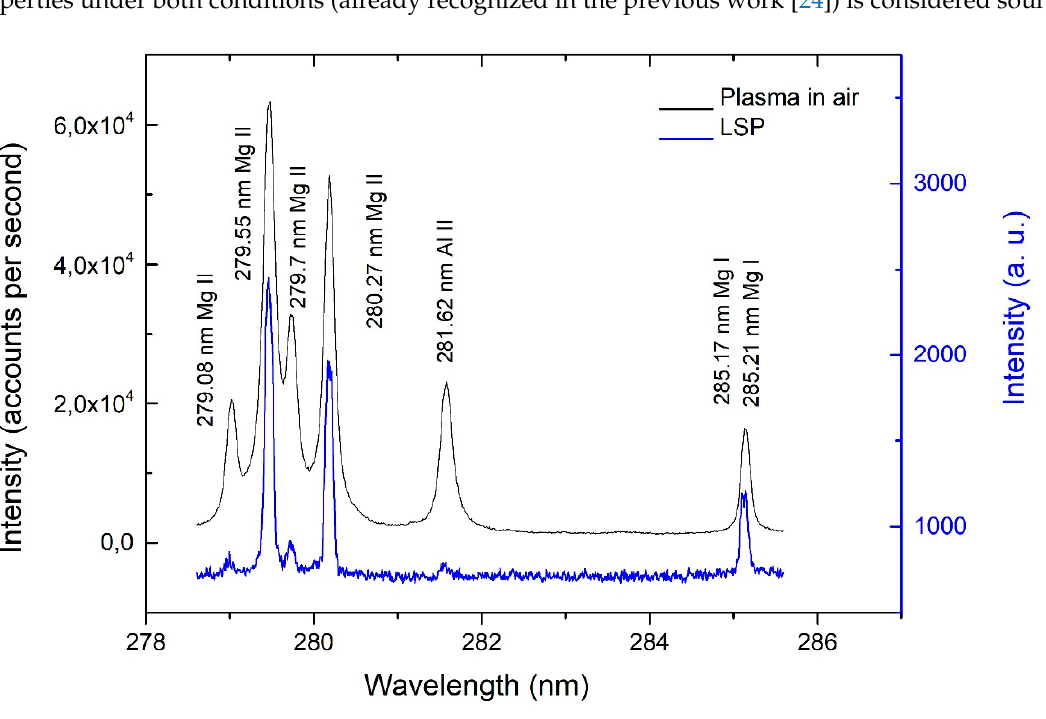
Figure 3. Mg II emission lines in air and LSP conditions. Delay time: 2 µs. Gate time: 1000 ns.